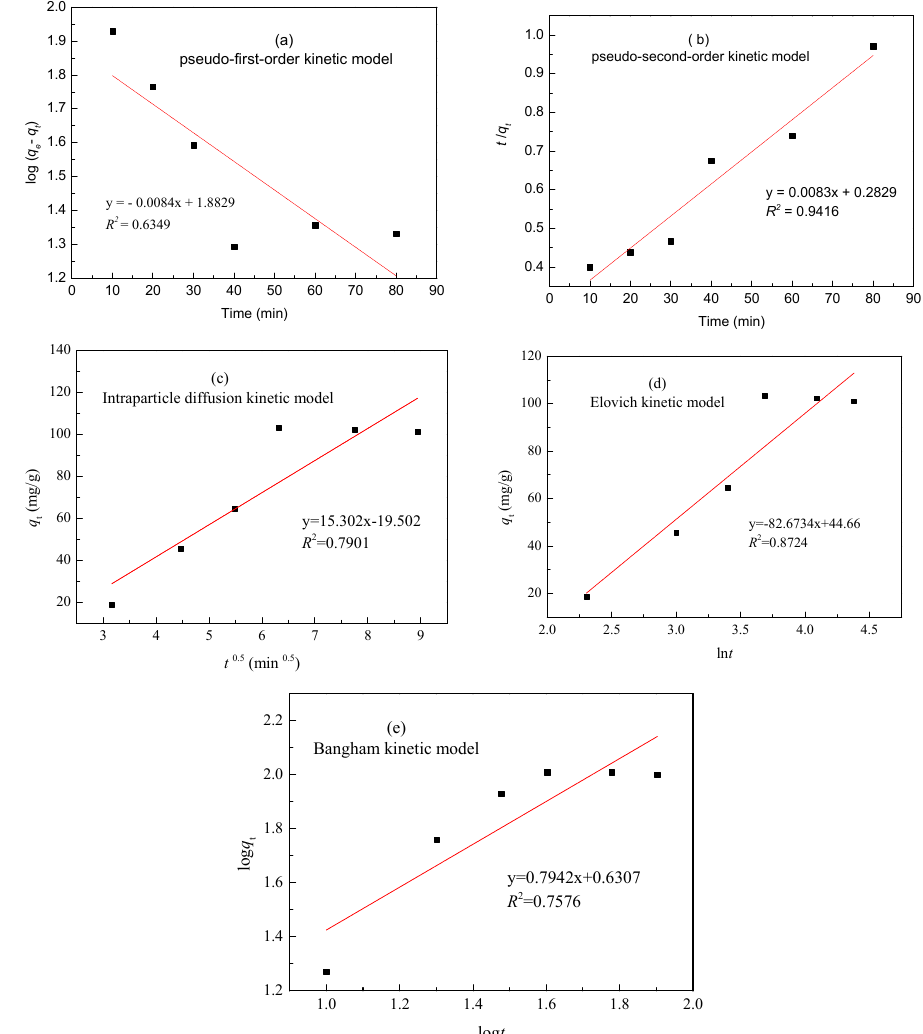
Figure 7. Pseudo-first-order ( a ); pseudo-second-order ( b ); intraparticle diffusion ( c ); Elovich ( d ) and Bangham ( e ) adsorption kinetic equations fitting curves of experimental data. (Adsorption experiments-sample dosage: 0.05 g; initial zinc(II) concentration: 0.015 mol/L; pH value: 5.16; temperature: 60 °C).